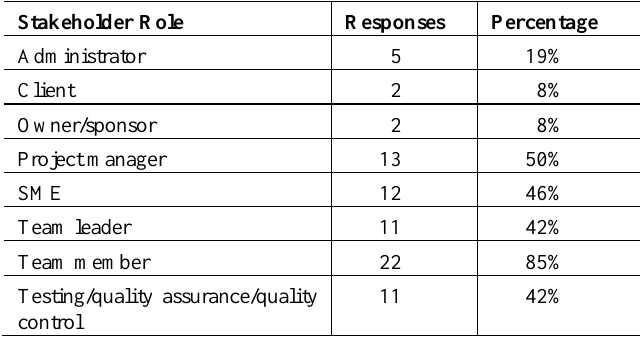
Table 3: Participants' roles in ICT project